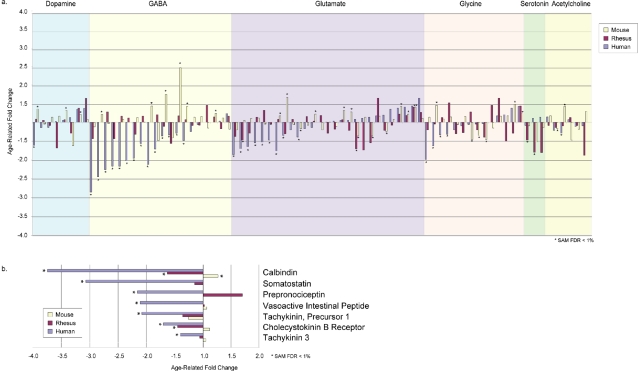
Global repression of genes associated with GABA-mediated inhibitory neurotransmission.Shown are age-related changes in the expression of genes that mediate major neurotransmitter systems in the cortex of humans, rhesus monkeys, and mice. a. Genes involved in specific neurotransmitters were identified based on membership in the corresponding GO groups. Age-related fold changes in genes with orthologs in all three species and represented on all three microarray platforms are shown for humans, rhesus monkeys, and mice. Gene identities are provided in Table S11. *q-value≤0.01. b. Age-related fold changes for markers of inhibitory neuronal subpopulations. Statistical significance in a specific species (q-value≤0.01) is denoted with an asterisk.